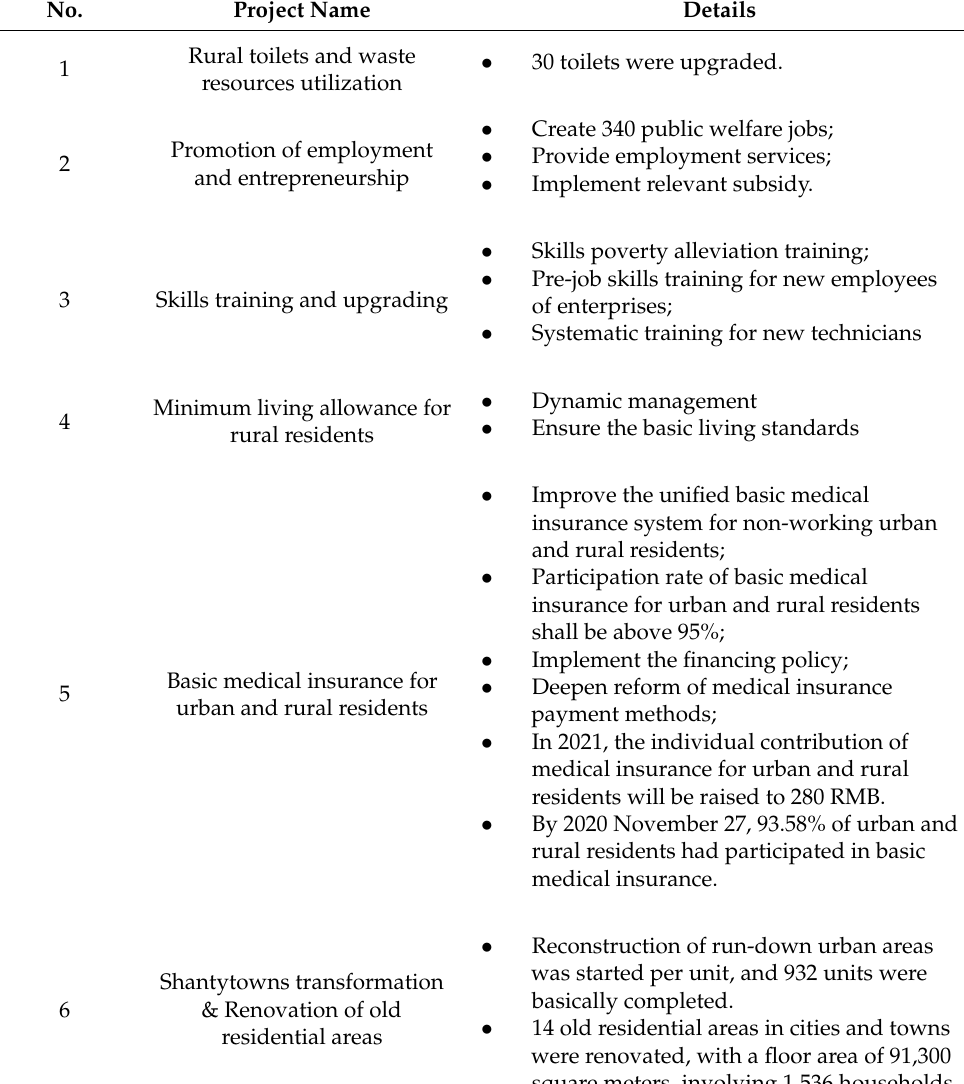
Table 2. Year 2020 people’s livelihood projects involved in L Coal Mine ecological